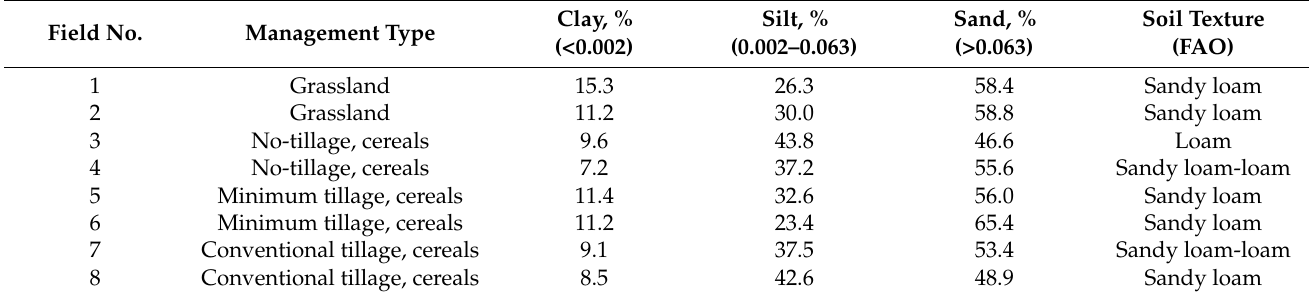
Table 1. Characteristics of the selected fields used in present